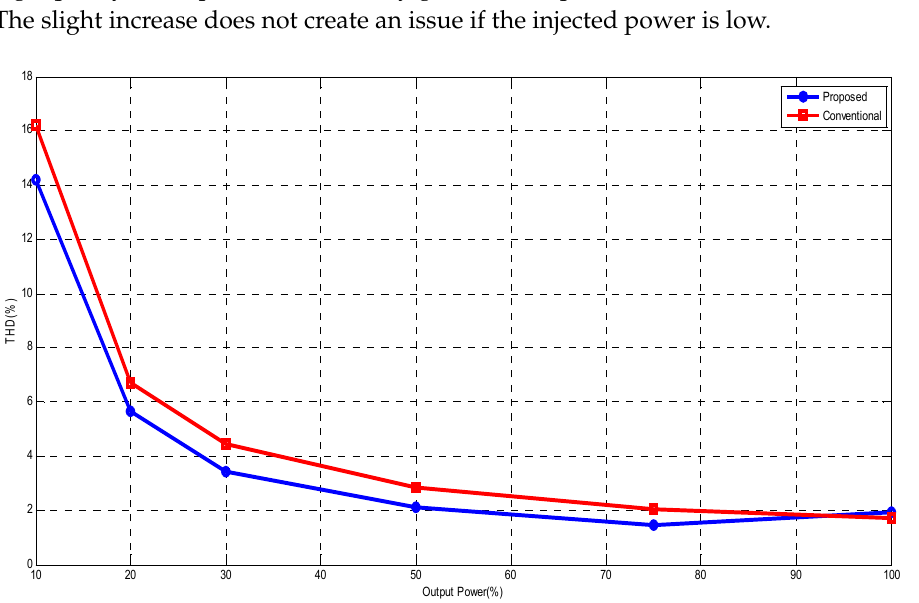
Figure 10. The variations of THD with output power of the conventional and proposed systems.